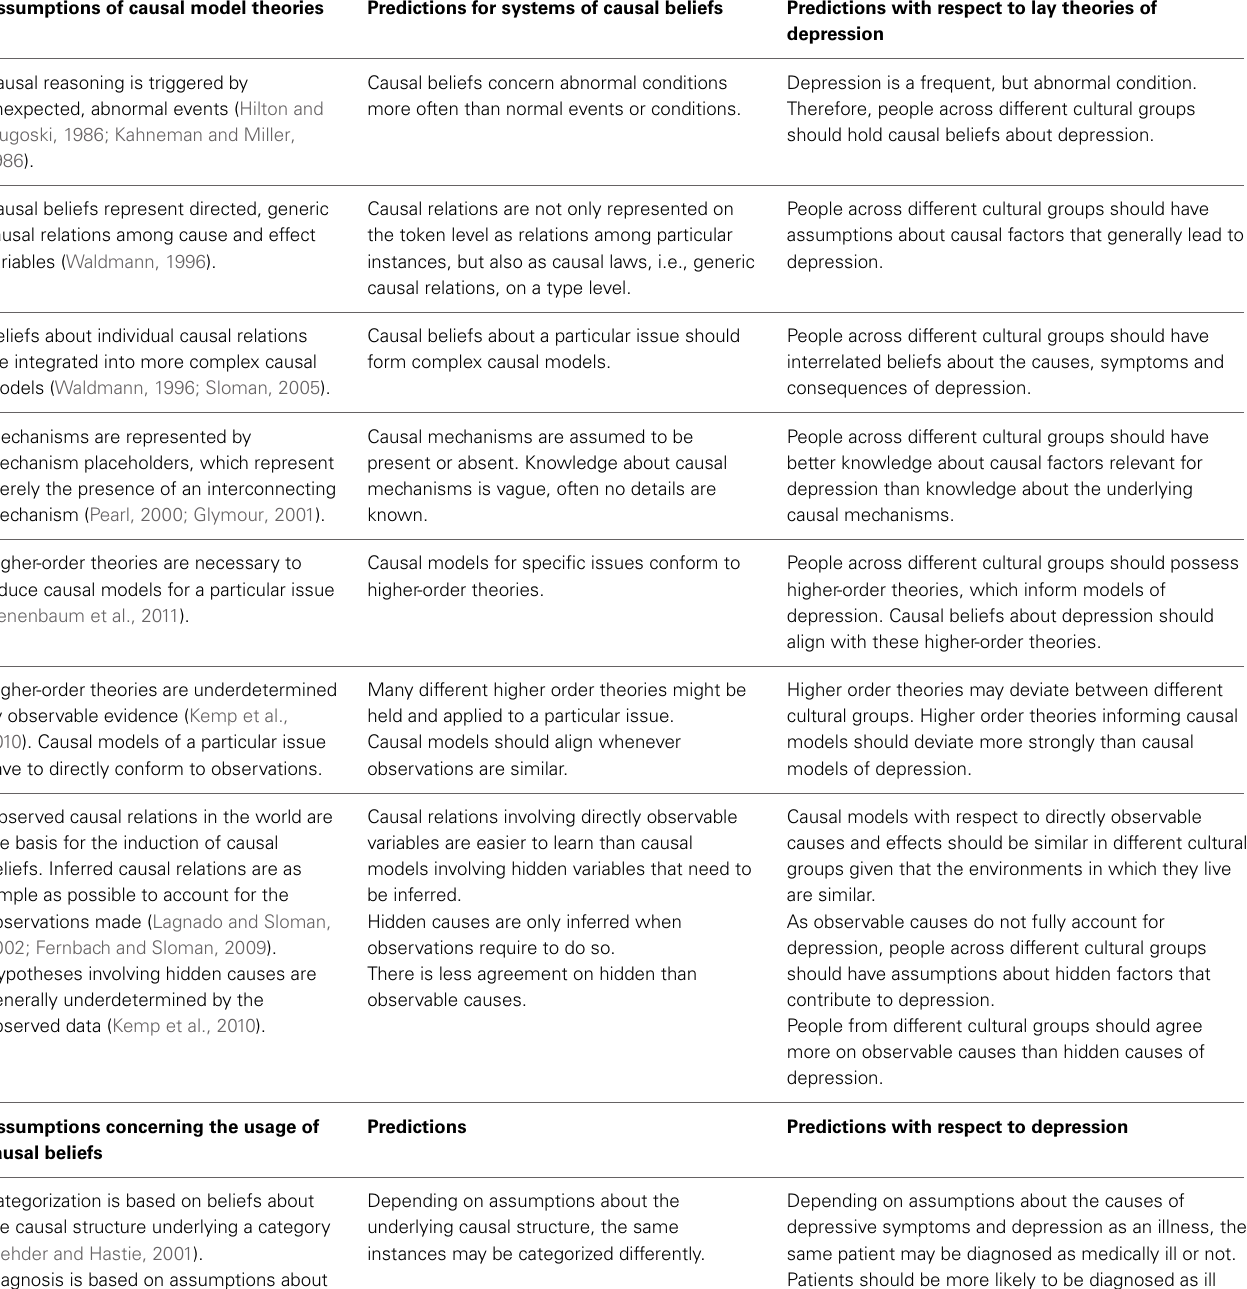
Table 1 | Predictions derived from causal model theories and respective research for systems of causal beliefs in general and beliefs about depression in